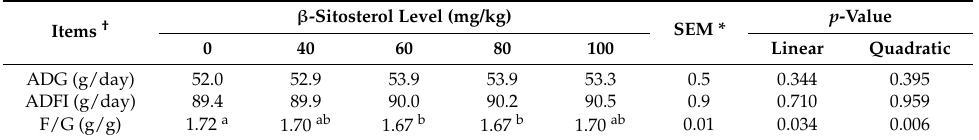
Table 3. Effect of dietary β -sitosterol supplementation at different levels on growth performance in